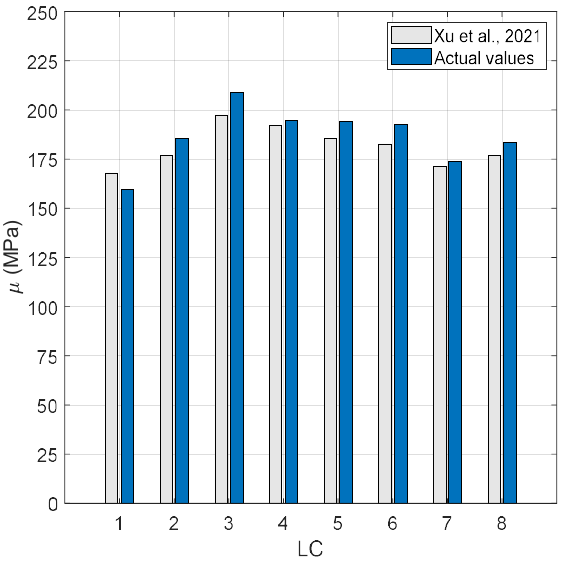
Figure 4. Comparative analysis—mean value of stress history in line #1.